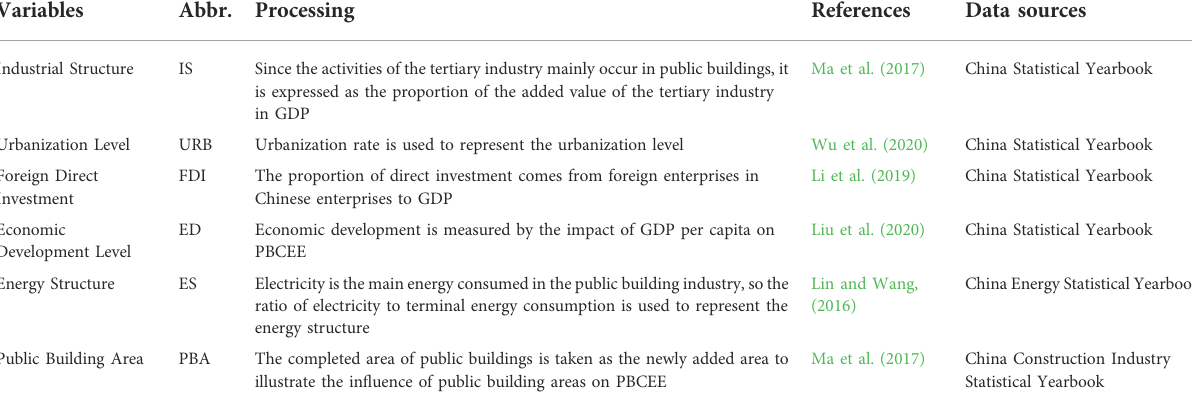
TABLE 2 In fl uencing factors and variable description of PBCEE.